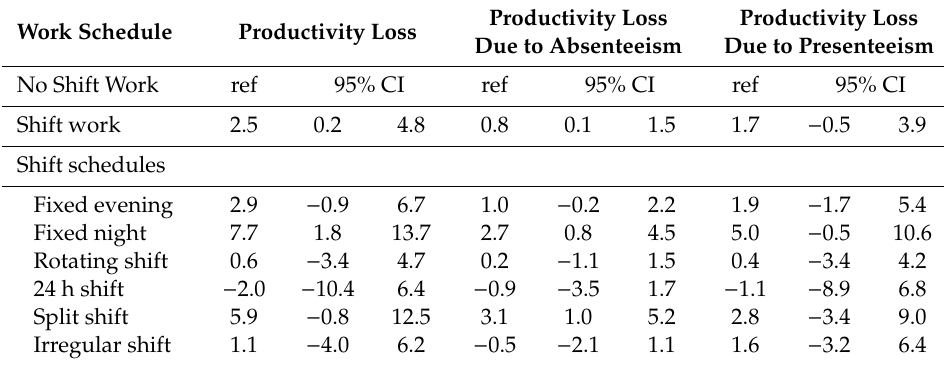
Table 2. Health-related productivity loss (HRPL) due to shift work and various shift schedules in the Korean working population (Unit: percent point).